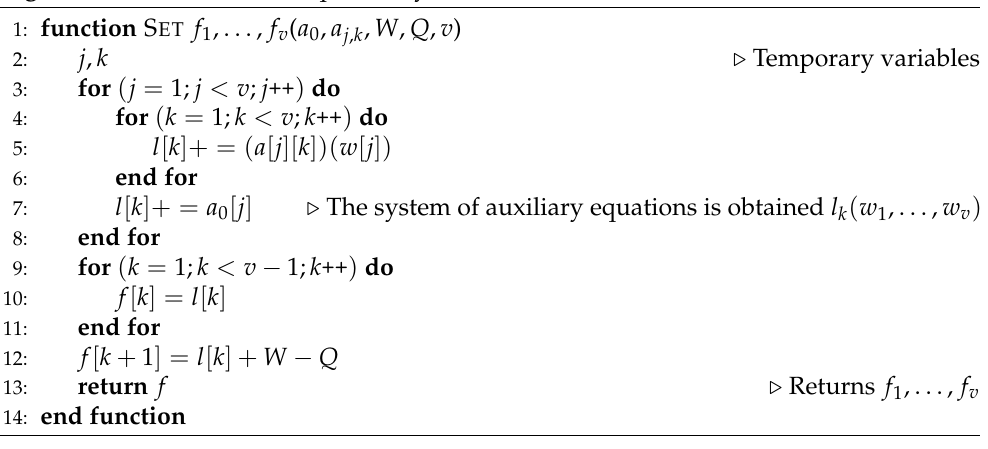
Algorithm 4 Set non-linear equation system to solve.